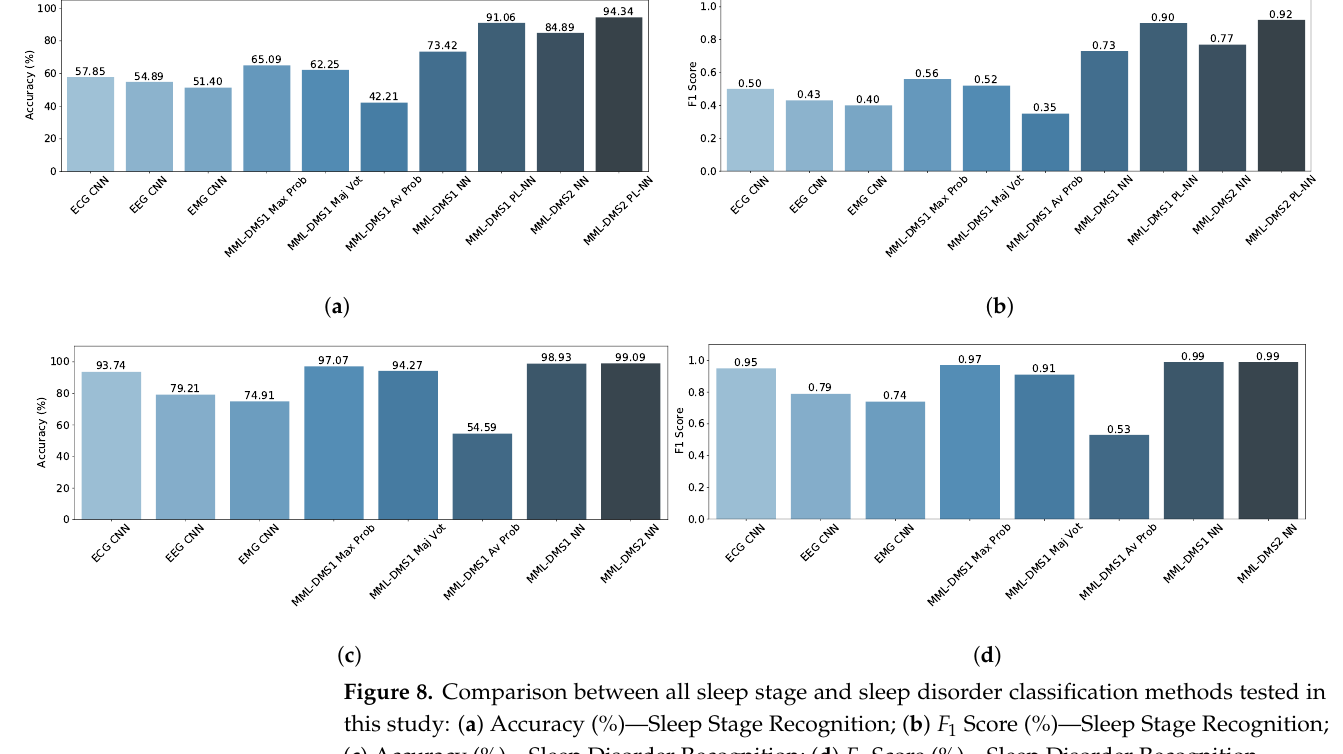
(ECG CNN, EEG CNN, and EMG CNN), four versions of the MML-DMS1 system each with a different decision-making method (MML-DMS1 MP, MML-DMS1 MV, MML-DMS1 AP, and MML-DMS1 NN), and one version of the MML-DMS2 with the NN trained from scratch (MML-DMS2 NN).